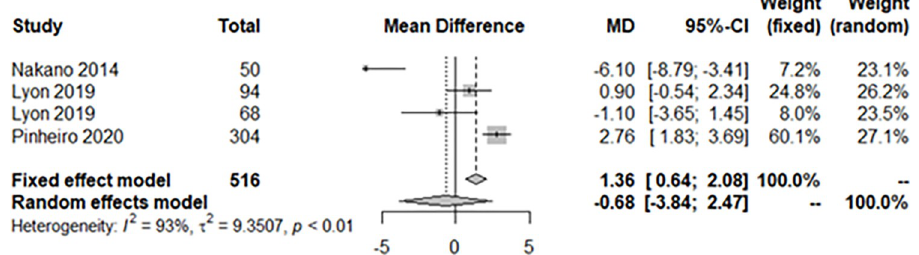
Fig 5. Overall pooled random-effects mean difference of apnea hypopnea index between smartphone and polysomnography across